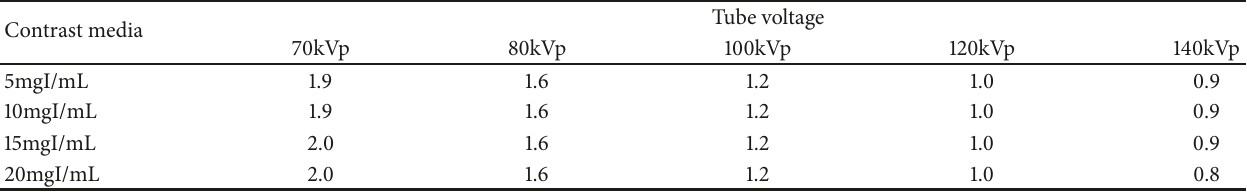
Table 1: Sensitivity for contrast media under conventional CT. CT numbers were measured from the images acquired under various kVp with diluted contrast media of 5-20 mgI/mL via conventional scans. The sensitivity was calculated by normalizing each CT number with the CT number at 120 kVp (100% at 120